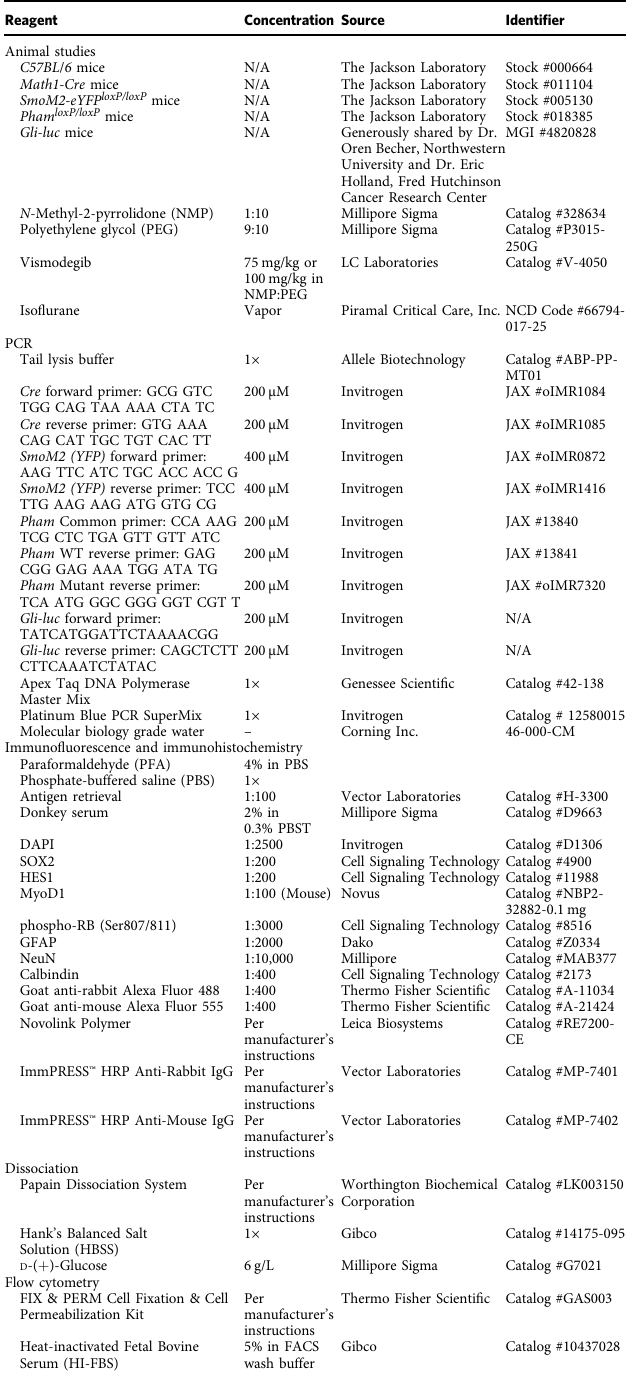
Supplementary Fig.